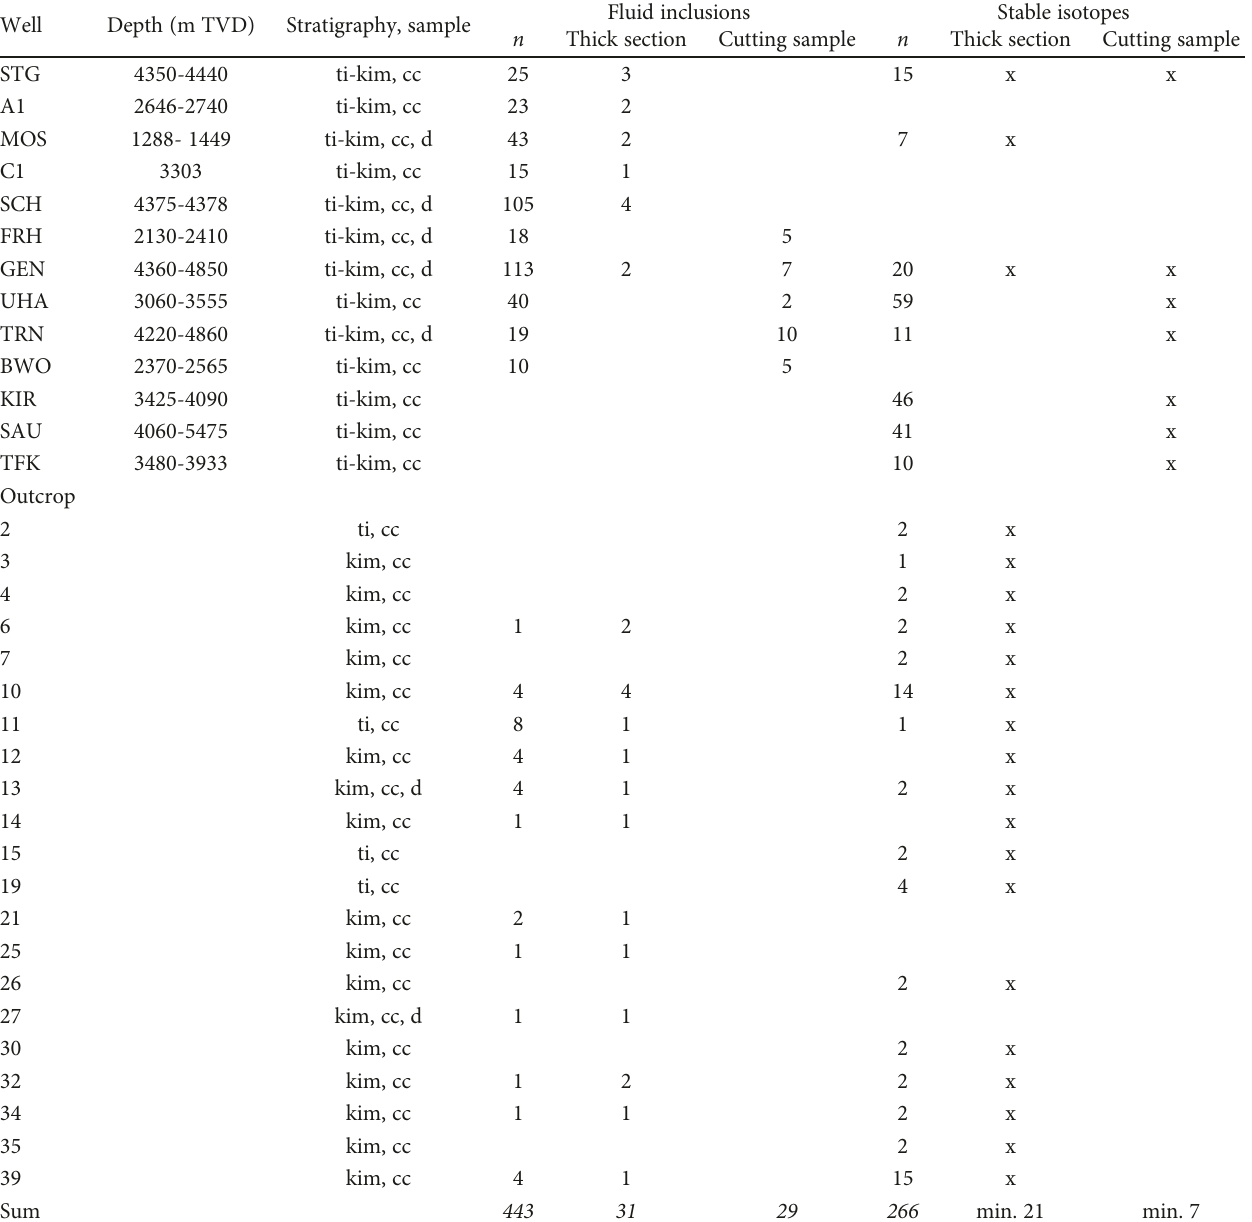
Table 1: Overview of the sampled wells and outcrops for the reconstruction of paleo fl uid composition and temperature in the Molasse Basin (Figure